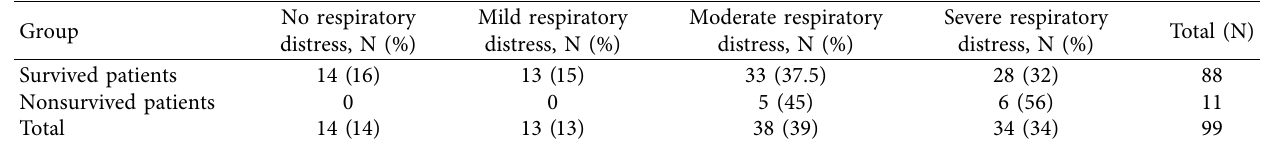
Table 2: The clinical respiratory score at the time of admission to the ICU.